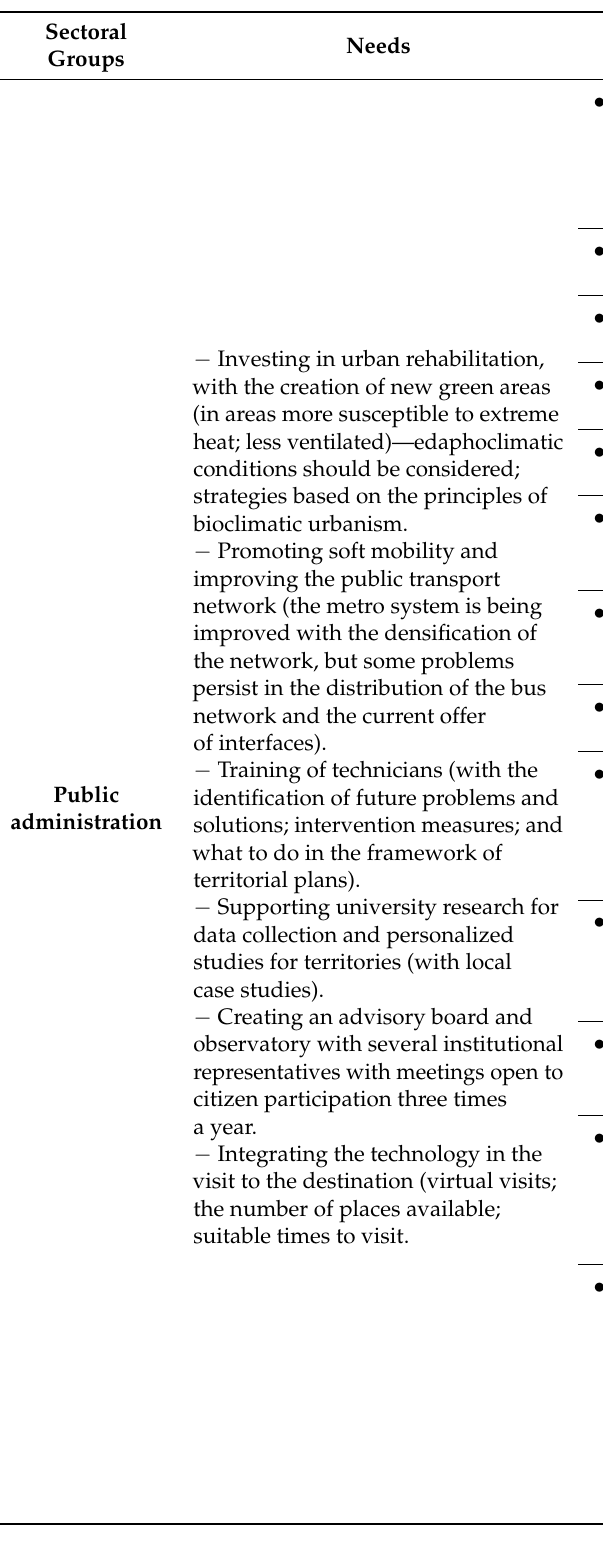
Table 5. Needs, resources, and solutions in adaptation responses to climate change in the urban tourism sector in